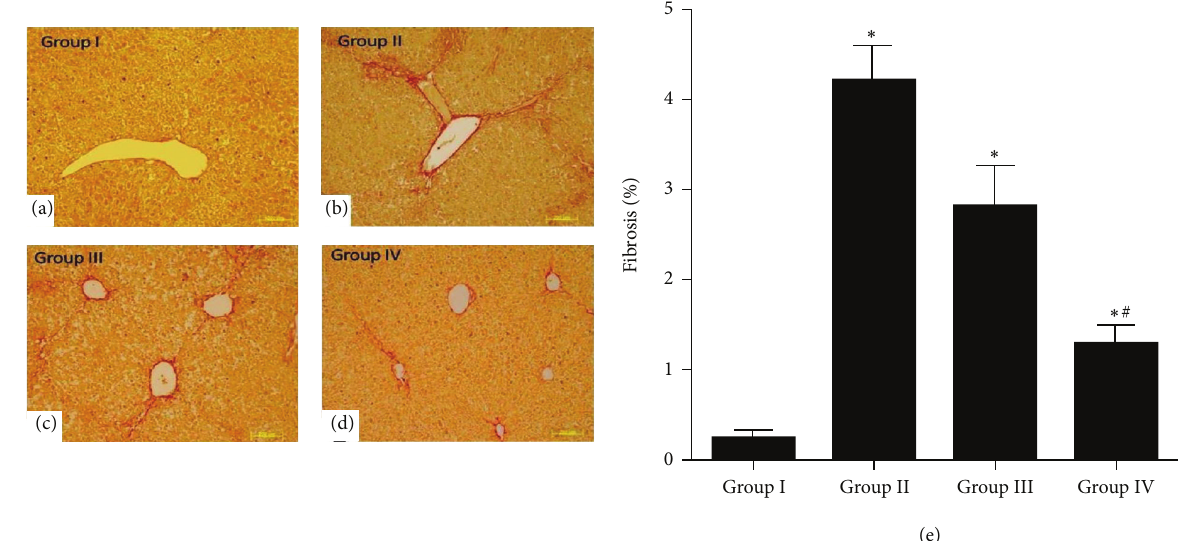
Figure 7: Sirius Red staining in liver section: (a–d) representing Groups I–IV; Sirius Red staining showed reduced collagen level in Group IV as compared to other groups (200x, scale bar ∼ 100 𝜇 m). (e) Bar graph represents percentage of fibrosis between the groups: ∗ P was < 0.05 for Group I versus Groups II, III, and IV. # 𝑃 < 0.05 for Group III versus Group IV.